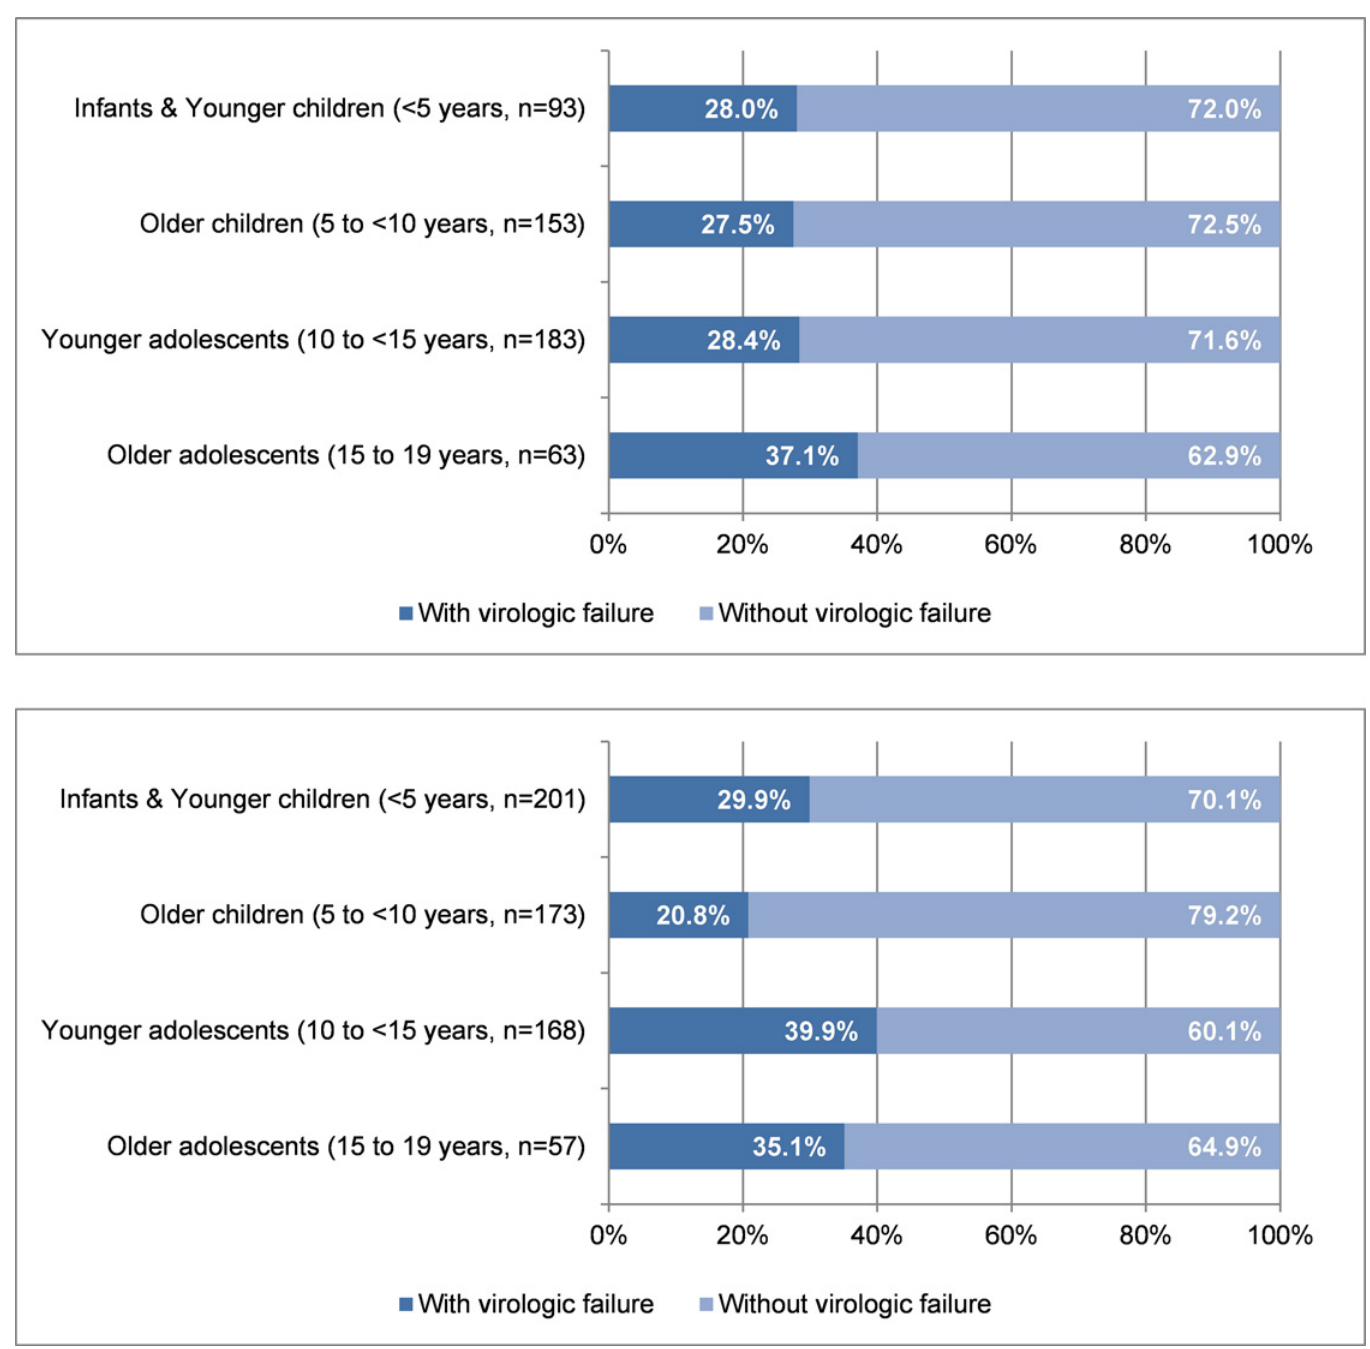
Fig 2. Virologic failure (a) by age group at cross-sectional evaluation (n = 599), (b) Virologic failure by age at ART initiation (n =